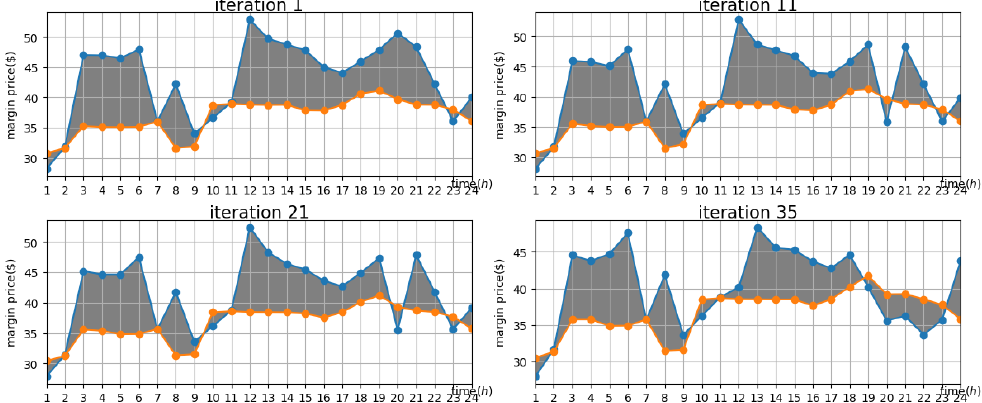
Figure 2. Tie-line during iteration process.